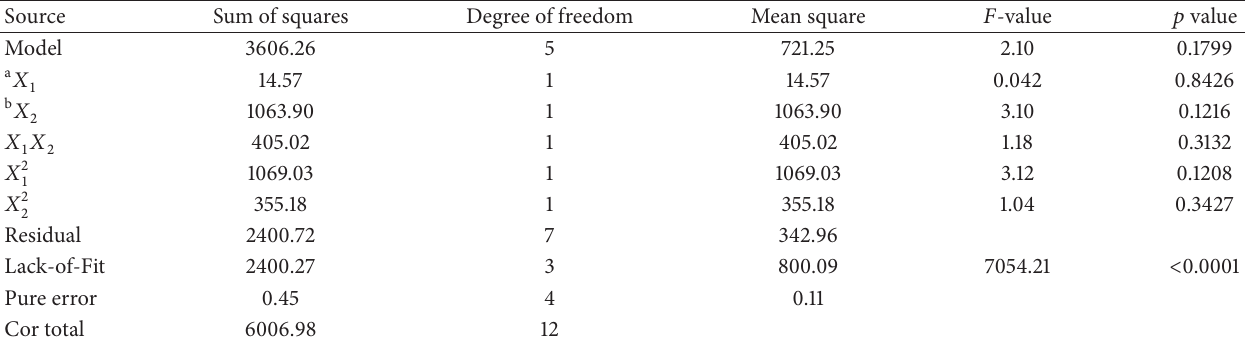
Table 7: Analysis of variance for Total Dry Weight (TDW) using